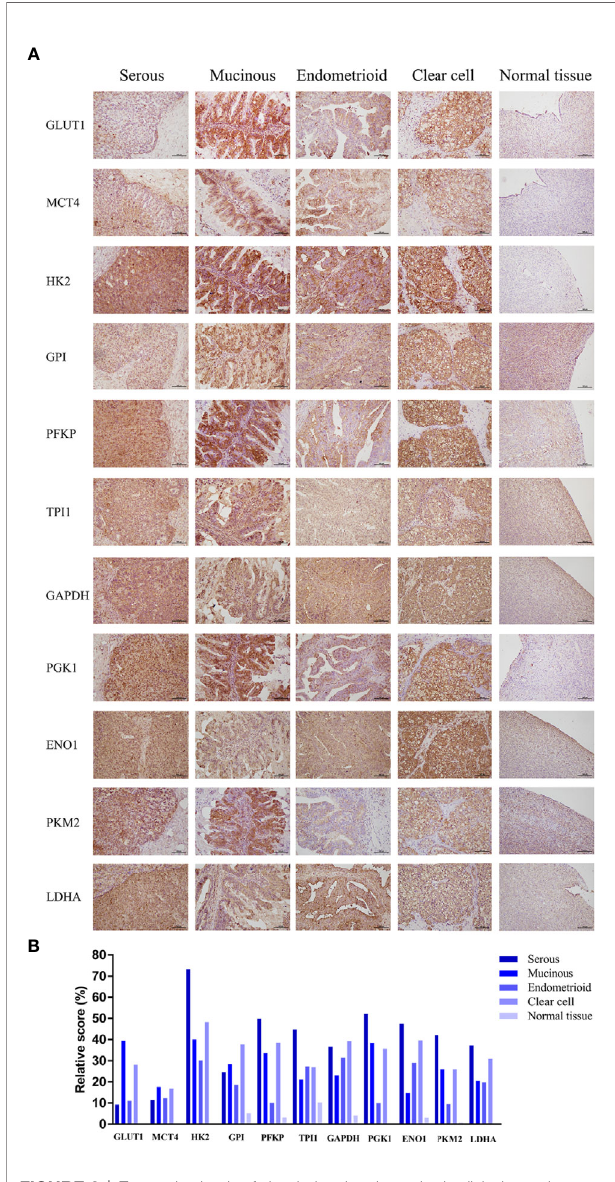
FIGURE 3 | Expressionlevels ofglycolysis-relatedproteinsinclinical samples. (A) Representativeimmunohistochemistryimages ofglycolysis-relatedproteins inepithelialovariancancer and normaltissue. (B) Immunostaining analysis using